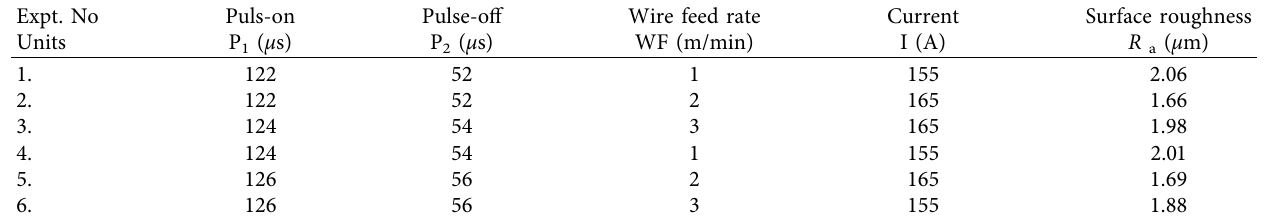
Table 7: Test datasets used in ANFIS